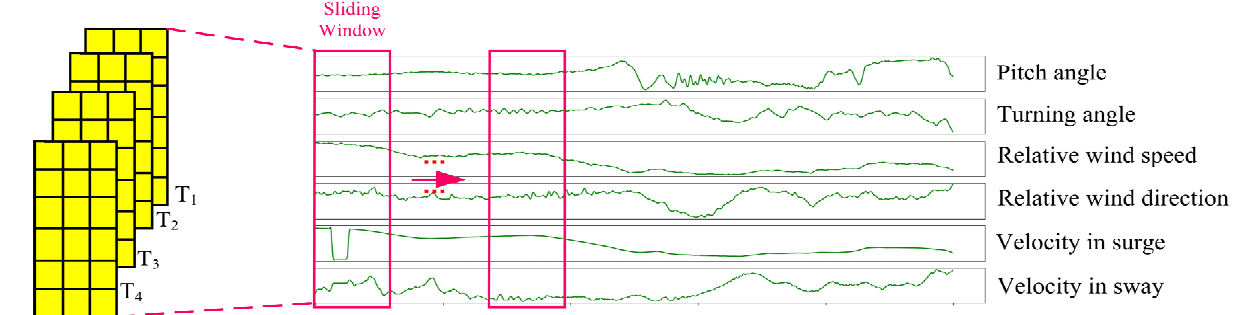
Figure 7. Flowchart of feature data transformation.